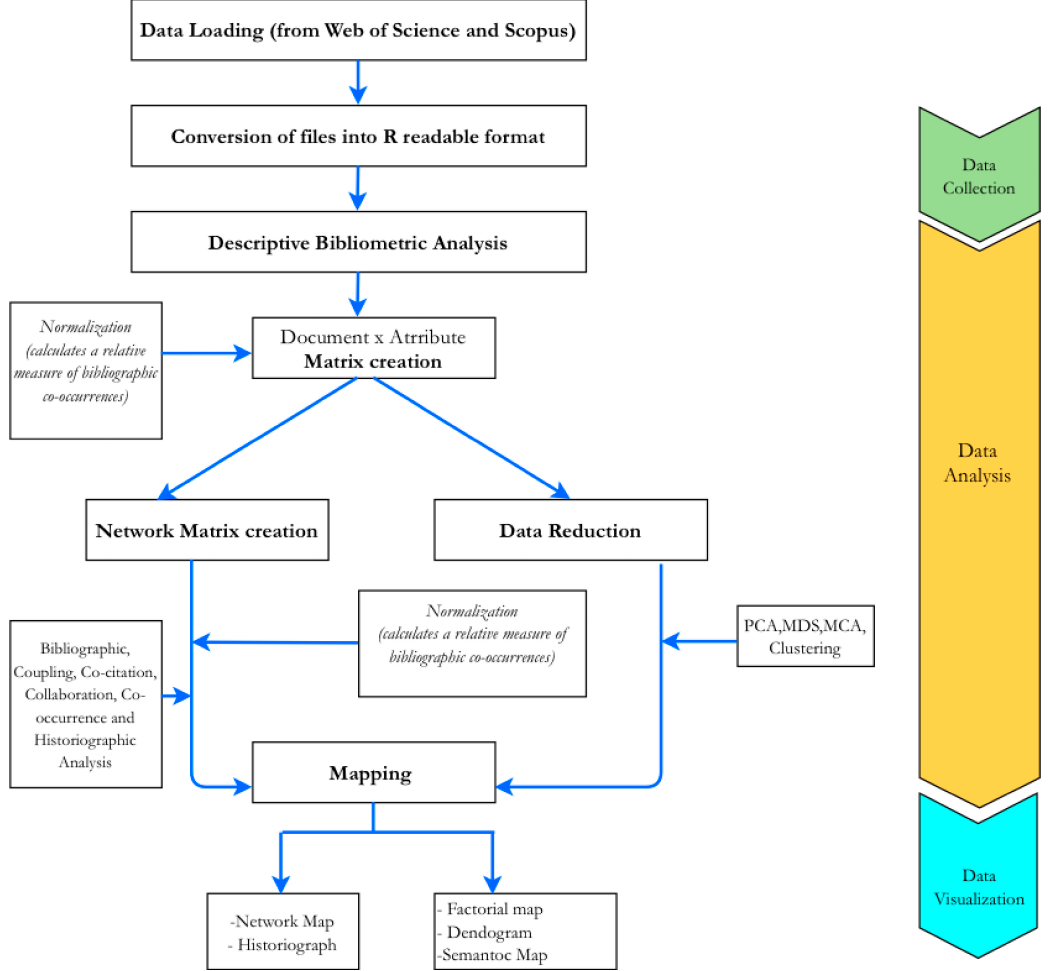
Figure 1. Research